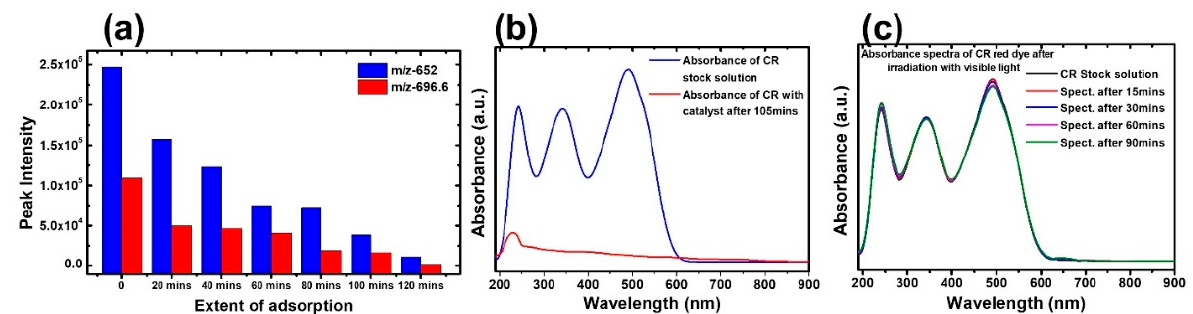
Table 2. M R and H C of the IONPs at various temperatures.